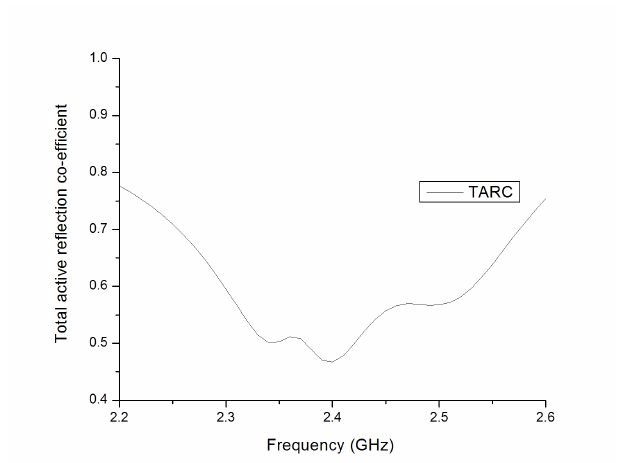
Figure 7: Simulated total active reflection